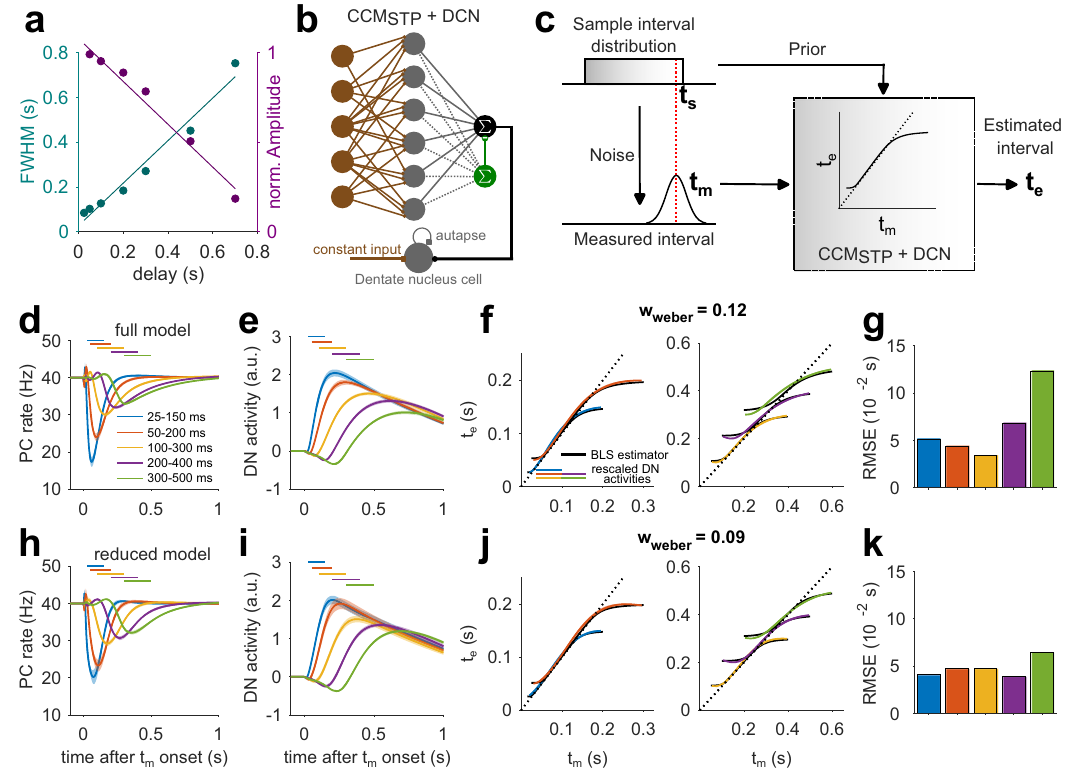
Fig. 6 | STP-generated temporal basis enables the computation of Bayesian time-interval estimates. a Full width at half maximum (cyan) and normalized amplitudes (magenta) of learned PC pauses versus delay interval from the experi- mentally constrained CCM STP (see Fig. 2). Solid lines are linear fi ts. b Scheme of CCM STP with added dentate nucleus cell. c Scheme of Bayesian integration. The sample interval t s (red dashed line, here drawn from a uniform distribution, upper left)issubjectto a noisy measurement yielding a measured interval t m (lowerleft). CCM STP implements Bayesian integration yielding an estimated interval t e (right). d PC responses after 12,000 learning trials, averaged over n = 20 simulations with